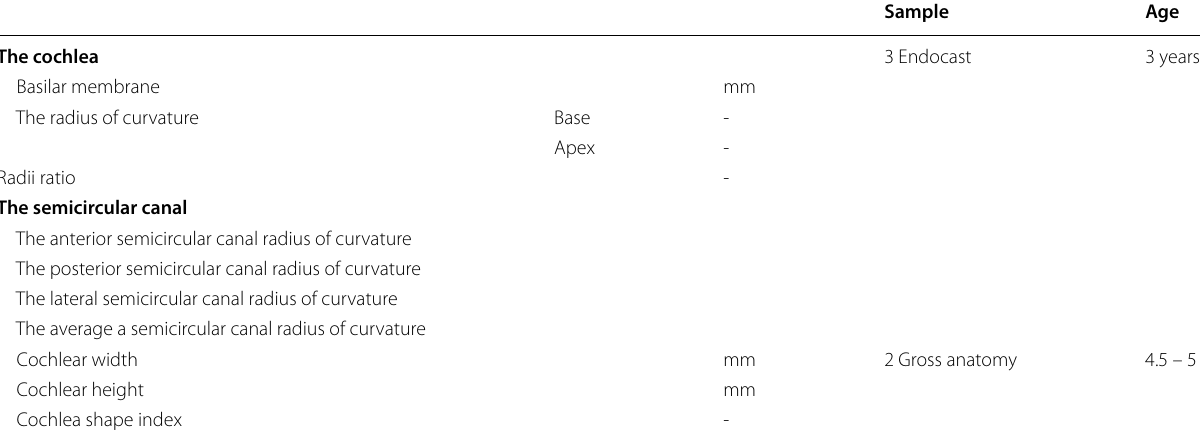
Table 1 The number of samples, the age of animals, and the technique